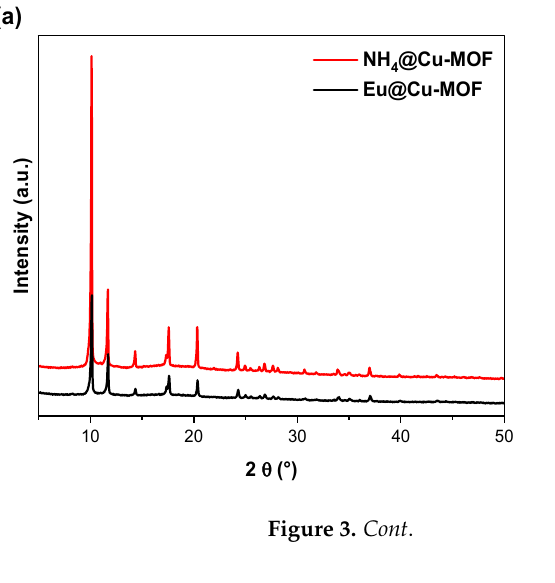
NH 4 @Cu-MOF and Eu@Cu-MOF materials. The XRD patterns (Figure 3a) showed no sig-